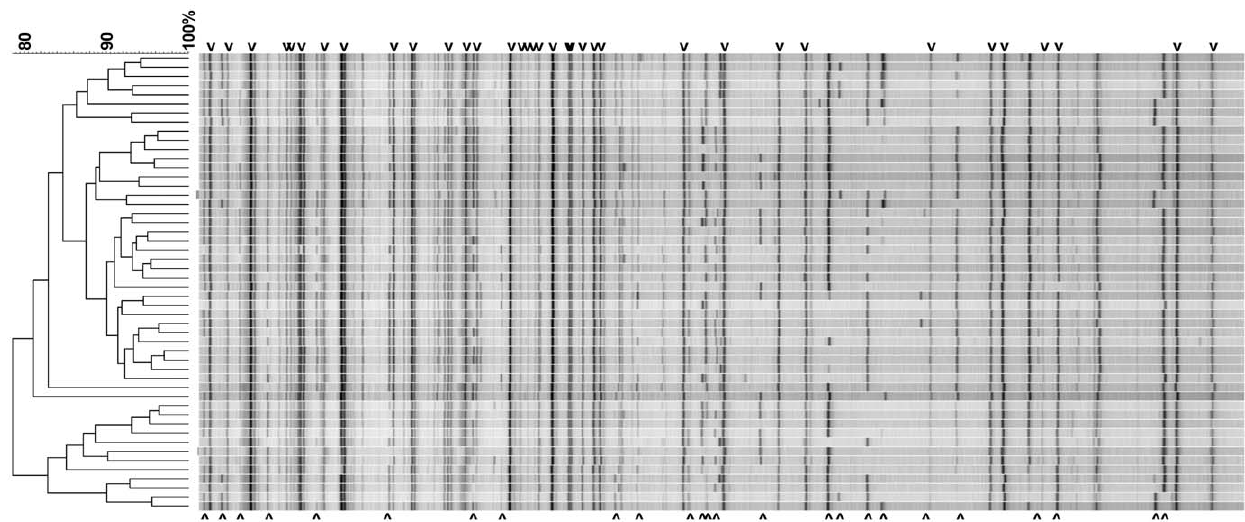
Figure 2. AFLP fingerprints of A.flavus . Representative fingerprints are shown for 50 randomly chosen isolates. The dendrogram is based on UPGMA clustering using the Pearson correlation coefficient. The scale bare indicates the percentage similarity. The fingerprints shown are restricted to DNA fragments in the range of 50–300 nt. Indicated with arrowheads above the fingerprints are some of the invariable bands, present in all isolates, that may constitute the core-genomic elements of A. flavus . Indicated with arrowheads below the fingerprints are some of the variable bands enabling discrimination between individual isolates.